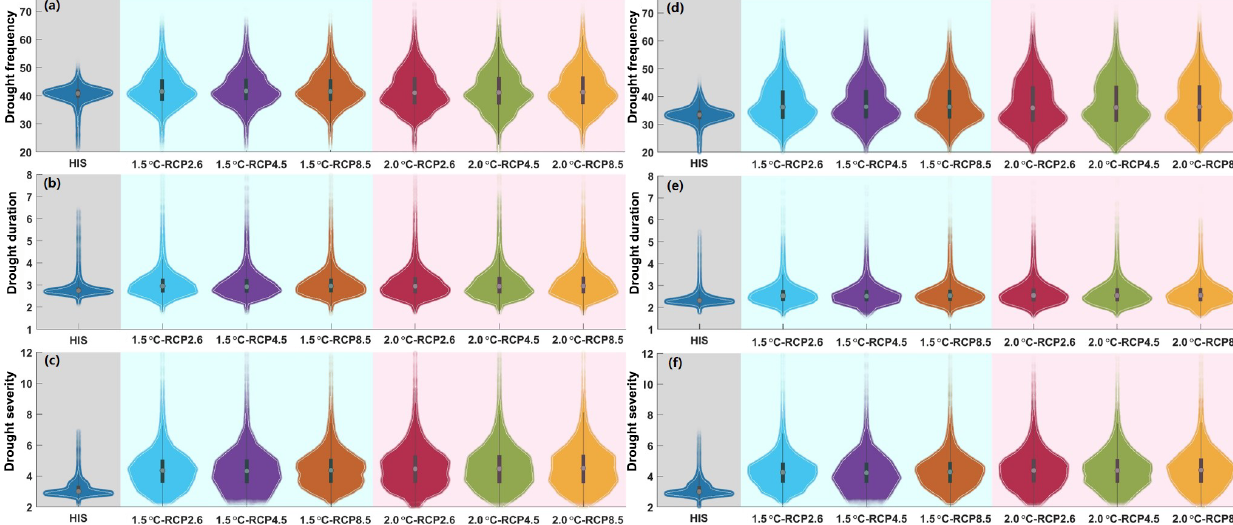
Figure 13. Distribution for drought characteristics when using − 0 . 5 as the threshold and − 0 . 8 as the threshold, respectively.